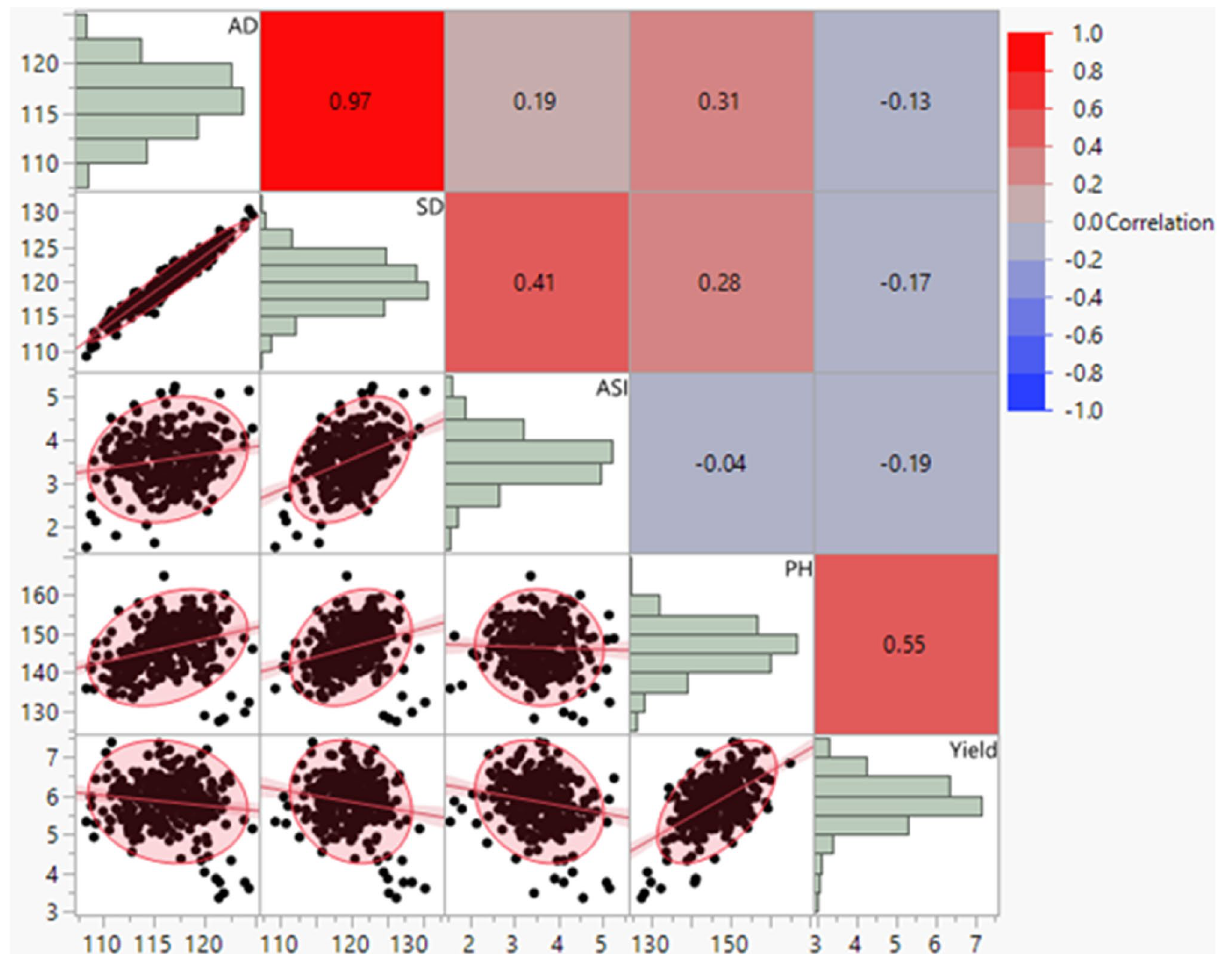
Figure 2. Scatter plot, frequency distribution and correlations coefficients among the traits recorded across cold stress locations (L2 to